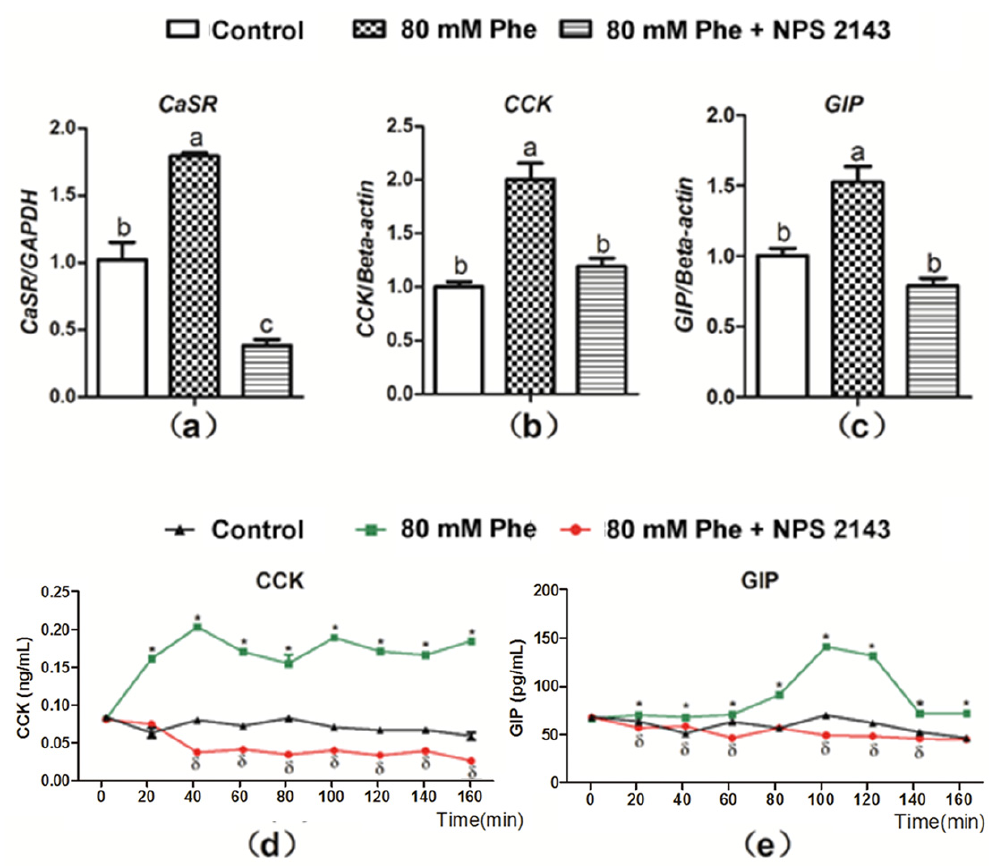
Figure 3. E ff ect of the CaSR antagonist NPS 2143 on Phe-induced mRNA expression of CaSR, CCK, and GIP, as well as secretion of CCK and GIP in pig duodenum. The tissues was perfused with 0 mM Phe (control group), 80 mM Phe, and 80 mM Phe with NPS 2143 (25 µ M), respectively. After 160 min of perfusion, tissues perfusate were harvested to detect the mRNA expression of ( a ) CaSR, ( b ) CCK, and ( c ) GIP, where Real-Time PCR, GAPDH, and β -actin were used as internal controls. During the perfusion, perfusate solutions were collected at intervals of 20 min to detect the concentrations of ( d ) CCK and ( e ) GIP by the ELISA assay. Values are presented as mean and SEM ( n = 5). For each gene ( a – c ), means without a common letter indicate a significant di ff erence at p < 0.05. For the same time-points ( d , e ), significant di ff erences at p < 0.05 are indicated by * and δ for treatment with 80 mM Phe and with the combination of NPS 2143 and 80 mM Phe, respectively, compared with the control group.